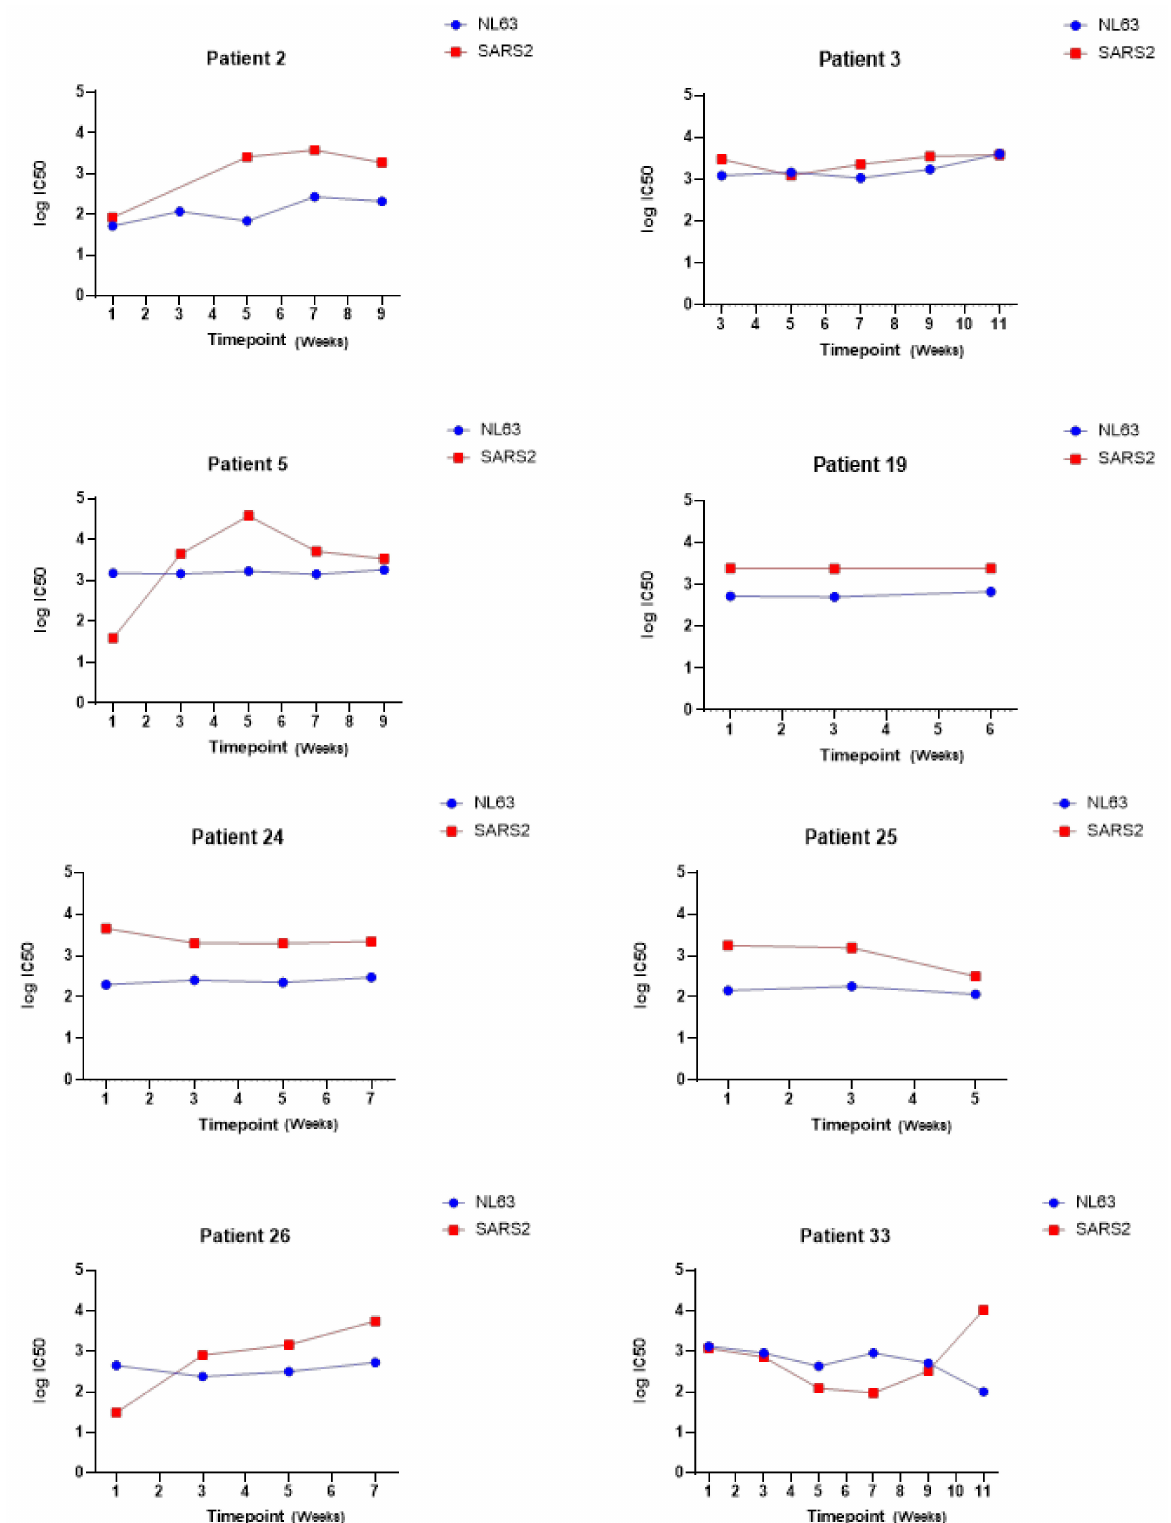
Figure 10. Example data showing log IC50 values for neutralization of HCoV-NL63 and SARS-CoV-2 at sequential time points in a cohort of patients hospitalized with COVID-19; samples were collected through the HICC consortium (https://www.hicc-consortium.com/, accessed on 10 May 2021). Serum samples were collected weekly with timepoint 1 representing a serum sample taken at